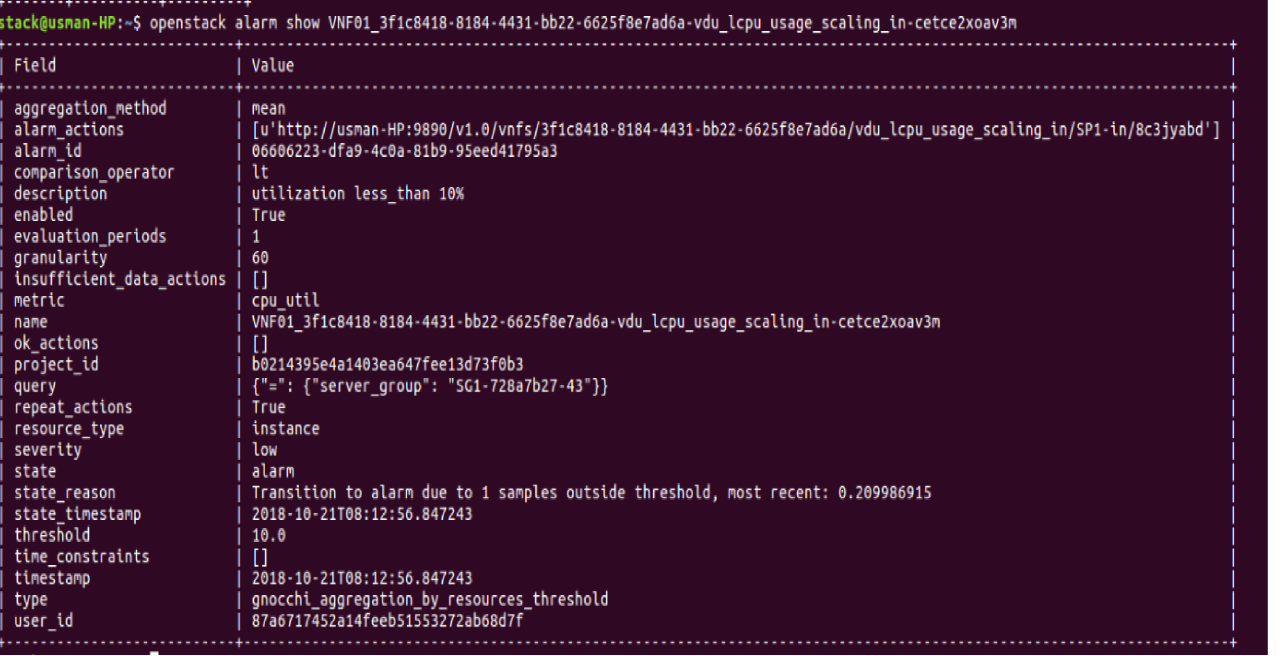
Figure 8. Aodh alarms Scale-in policy parameters.